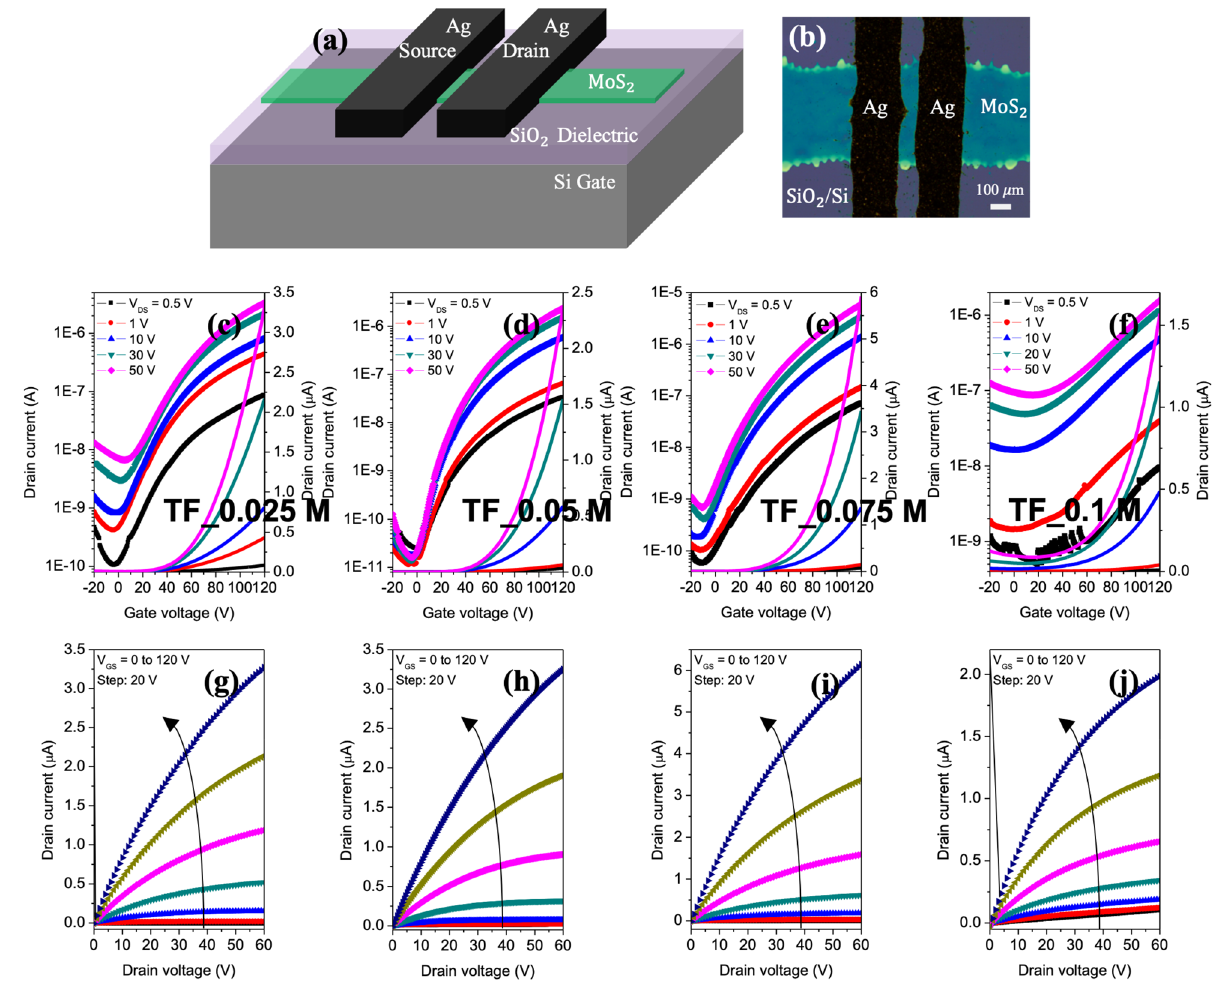
Figure 5. ( a ) Diagram of transferred MoS 2 TFT devices with Ag as S/D. ( b ) Microscope image of a typical transferred TFT having patterned Ag S/D and patterned MoS 2 . ( c – f ) Transfer and ( g – j ) output curves of the